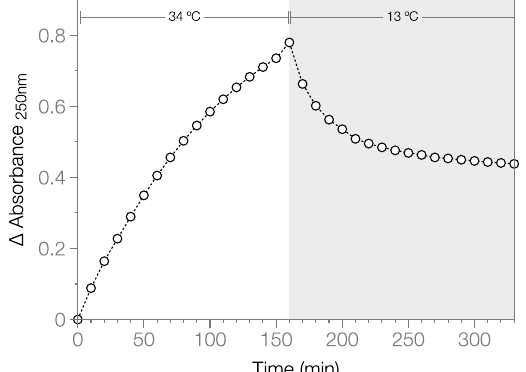
Figure 4. Disassembly of RSV CA tubes followed using classical light scattering. RSV CA (300 μ M) in 12.5 mM MOPS/KOH pH 7.0, 75 mM NaCl, 10%(w/v) Ficoll 400 was incubated at 34 °C for 3 hours, while the apparent absorbance at 250 nm was monitored. The temperature was then dropped to 13 °C, and absorbance measurements continued for a further 3 hours. The displayed data are the mean of duplicate